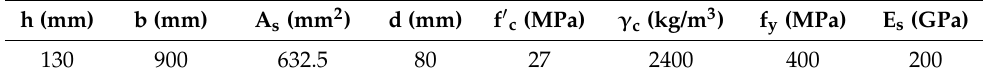
Figure 3. Reference slab reinforcement details. Table 1. Mechanical properties and dimensions of reference slab.